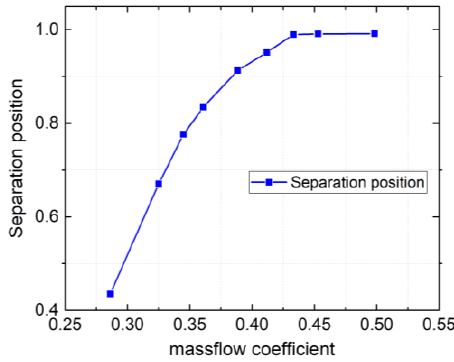
Figure 11. Pressure distribution at pitchwise to different mass-flow coefficients. 4.3. Selection of Parameters of Excitation Unsteady excitations can cause an influence on mass-flow rate as well as pressure raise and efficiency, which makes it difficult to make a comparison between the effects under different